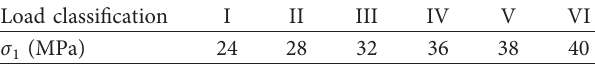
Table 2: Uniaxial loading rheological test scheme.